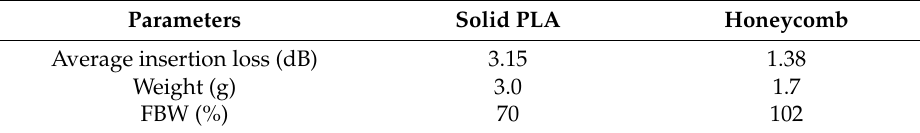
Table 2. Performance comparison of SIWs with solid PLA and the proposed honeycomb. Parameters Solid